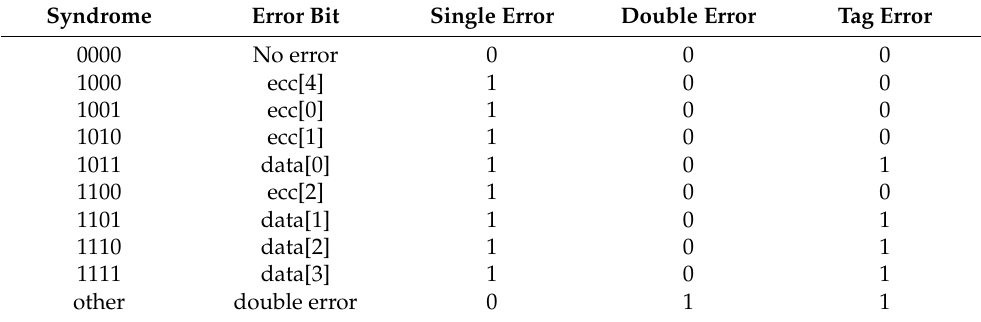
Table 3. Error detection